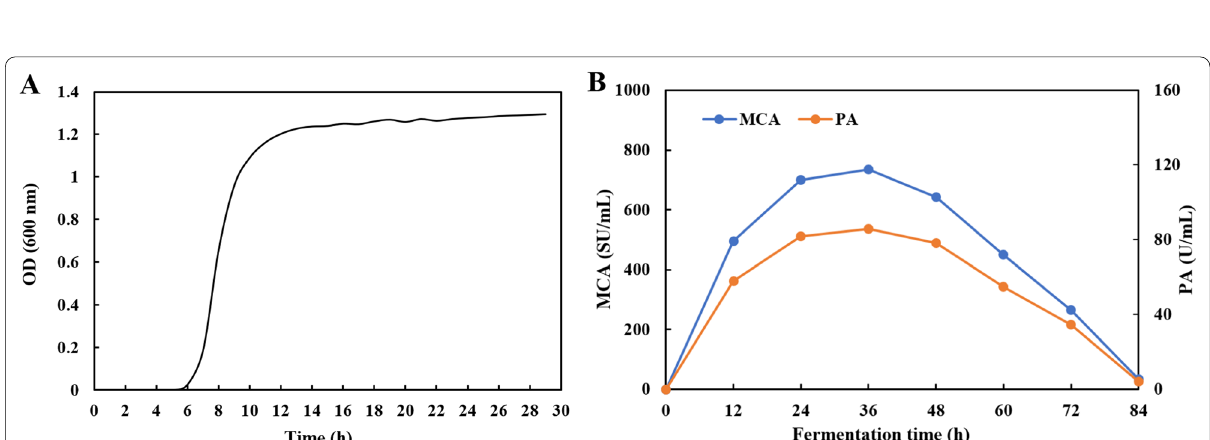
Fig. 2 Growth of Bacillus velezensis DB219 in modified TYC medium within 30 h ( A ) and DB219 MCE production during different fermentation times (12–84 h) ( B ). The data are represented as mean